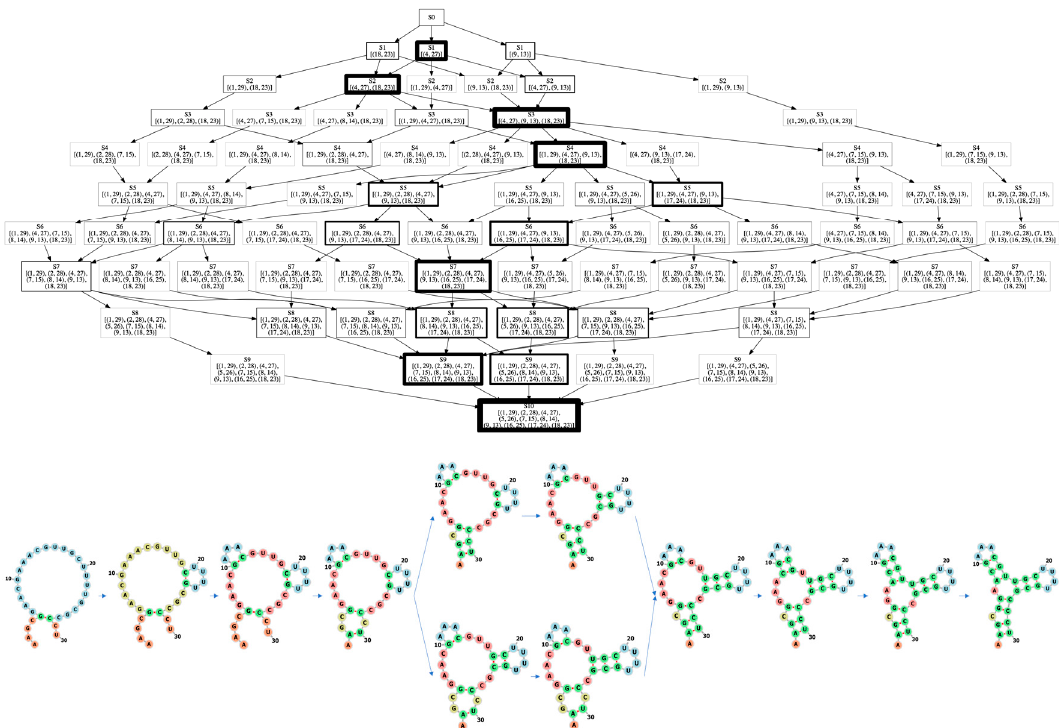
Figure 5. The learned fastest folding path of an RNA. The top is the folding path tree, each box represents a state, the thickness of the box represents the number of passes. The darker the color, the more times this state have been passed. The number in box is the indexes of the paired residues. And the bottom is the visualized folding path.